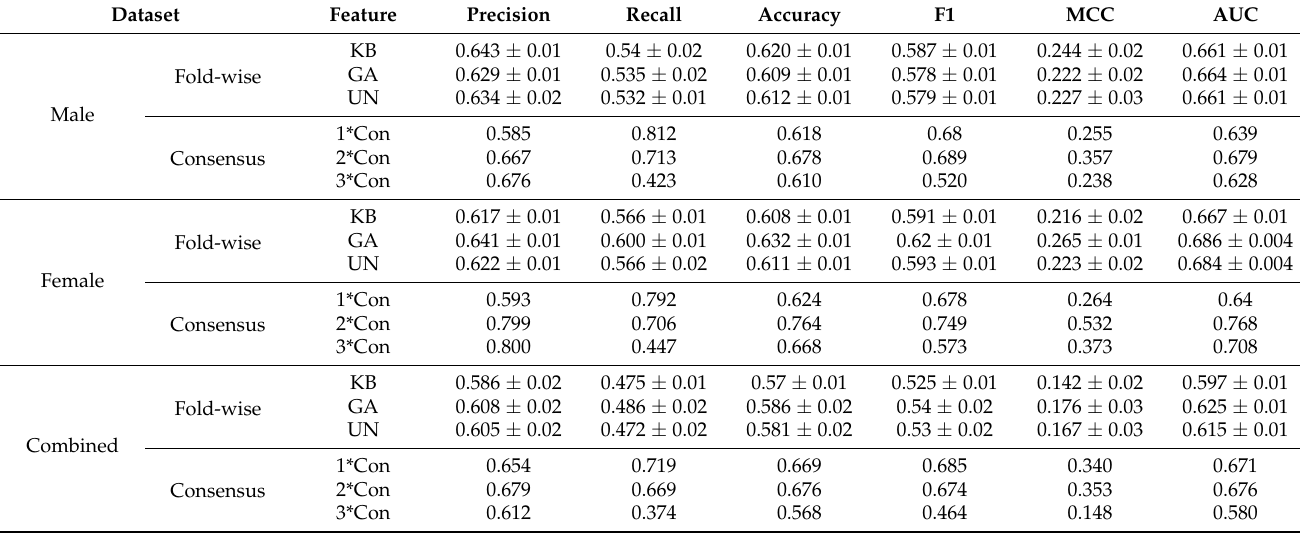
Table 2. Performance evaluation using fold-wise and consensus strategy on hold-out test